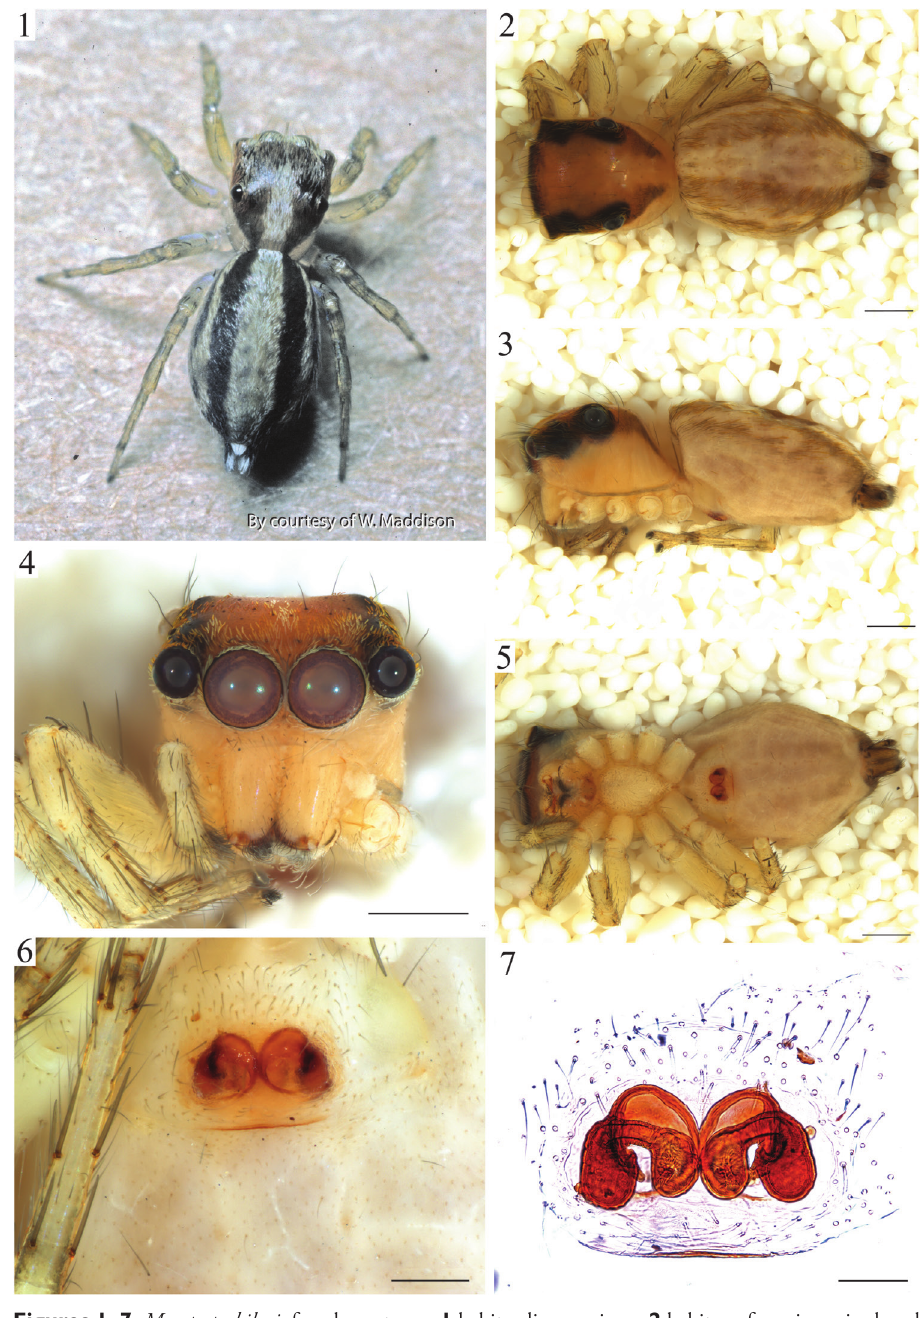
Figures 1–7. M. setastrobilaris female anatomy. 1 habitus live specimen 2 habitus of specimen in dorsal view 3 same lateral view 4 prosoma anterior view 5 habitus ventral view 6 epigynum ventral view 7 epigy- num dorsal view (cleared). Scale bars 0.5 mm ( 2–5 ); 0.2 mm ( 6 ); and 0.1 mm ( 7